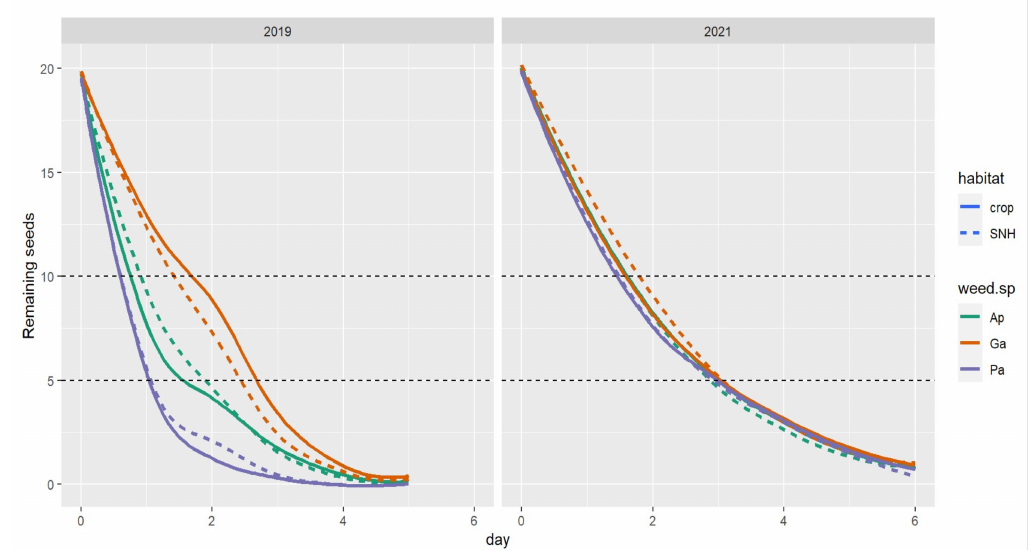
Figure 3. Temporal patterns of seed predation of weed species Ap: Apera spica-venti , Ga: Galium aparine , and Pa: Papaver rhoeas , exposed to seed predation inside the winter wheat field and the adjacent SNH in 2019 and 2021, Gödöll˝o, Hungary. The figure was created based on the daily data collection where the lines are smooth to demonstrate better the trend of change on seed predation.